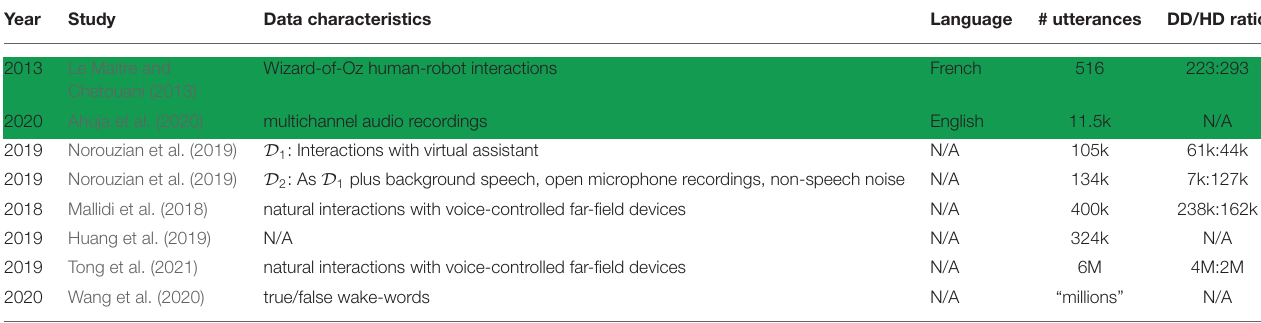
TABLE 2 | Overview of utilized in-house data, sorted by number (#) of